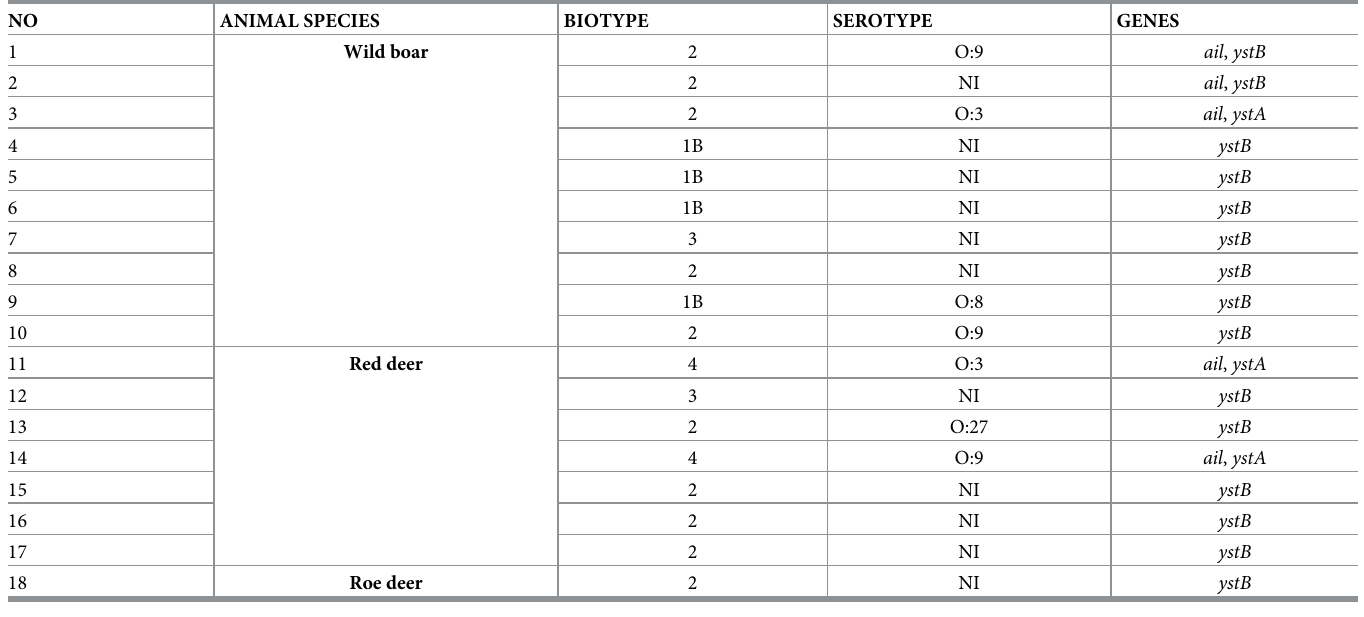
Table 4. The prevalence of ail , ystA and ystB genes in Yersinia enterocolitica biotype 1B, 2–4 isolates from game